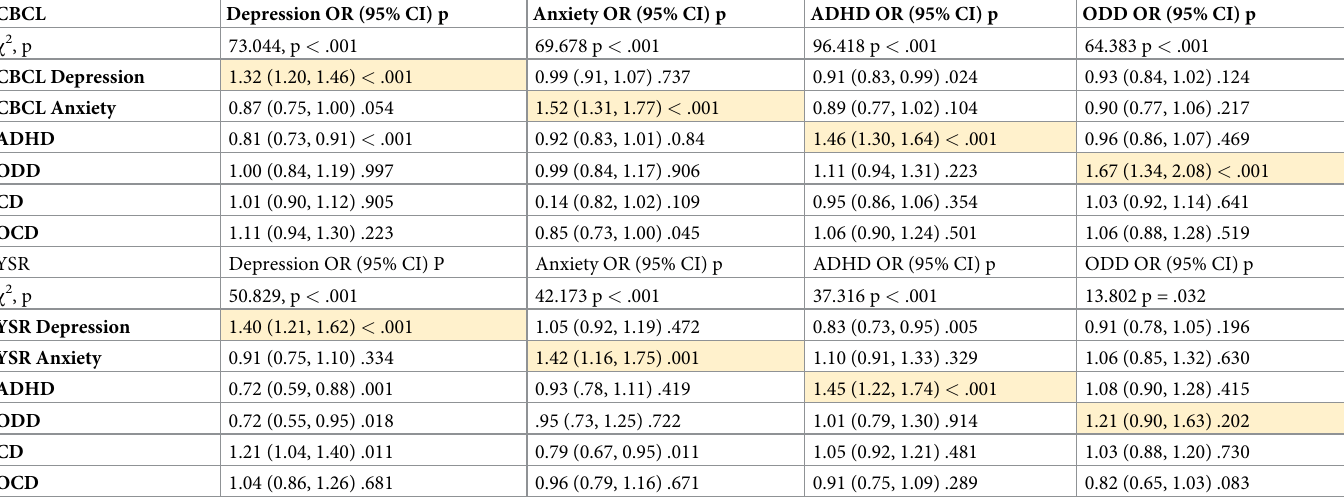
Table 4. Convergent/Divergent validity of the CBCL and YSR DOS versus LEAD diagnoses using multivariate logistic regression where the odds ratio (OR) refers to the likelihood of a diagnosis for every additional score point on each